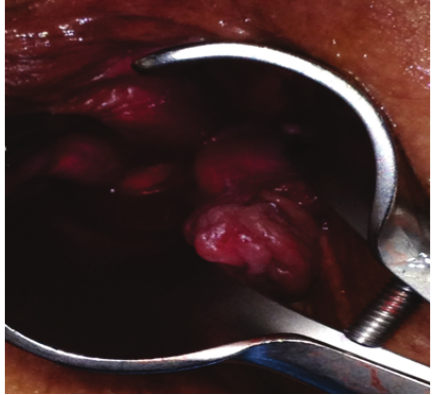
Figure 1: Dieulafoy lesion with fresh bleeding in anal